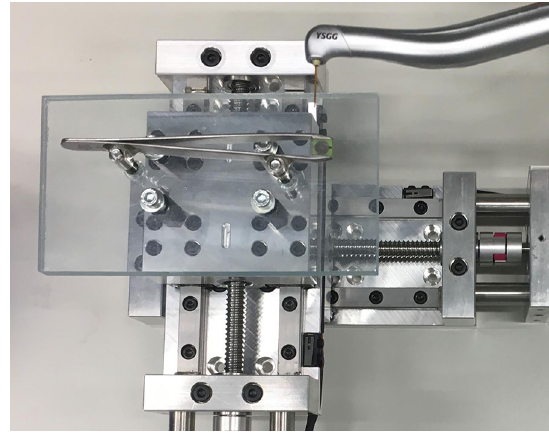
Fig. 2 Translations desk with support for titanium discs and Er,Cr:YSGG laser with side-firing tip